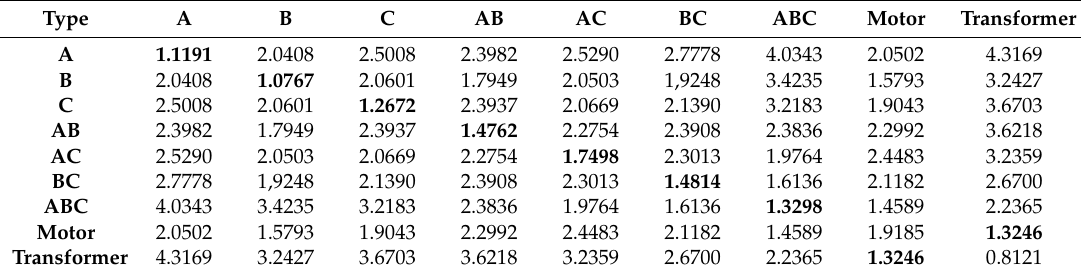
Figure 9. Voltage sag feature distribution in three dimensions. ( a ) Voltage sag feature distribution of A/B/C signal-phase short-circuit faults; ( b ) voltage sag feature distribution of AB/AC/BC two-phase short-circuit faults; ( c ) voltage sag feature distribution of A/AB/ABC-phase short-circuit faults; ( d ) voltage sag feature distribution of three-phase short circuit/motor starting/transformer energizing. Table 2. Euclidean distances of the features for different types of voltage sags.